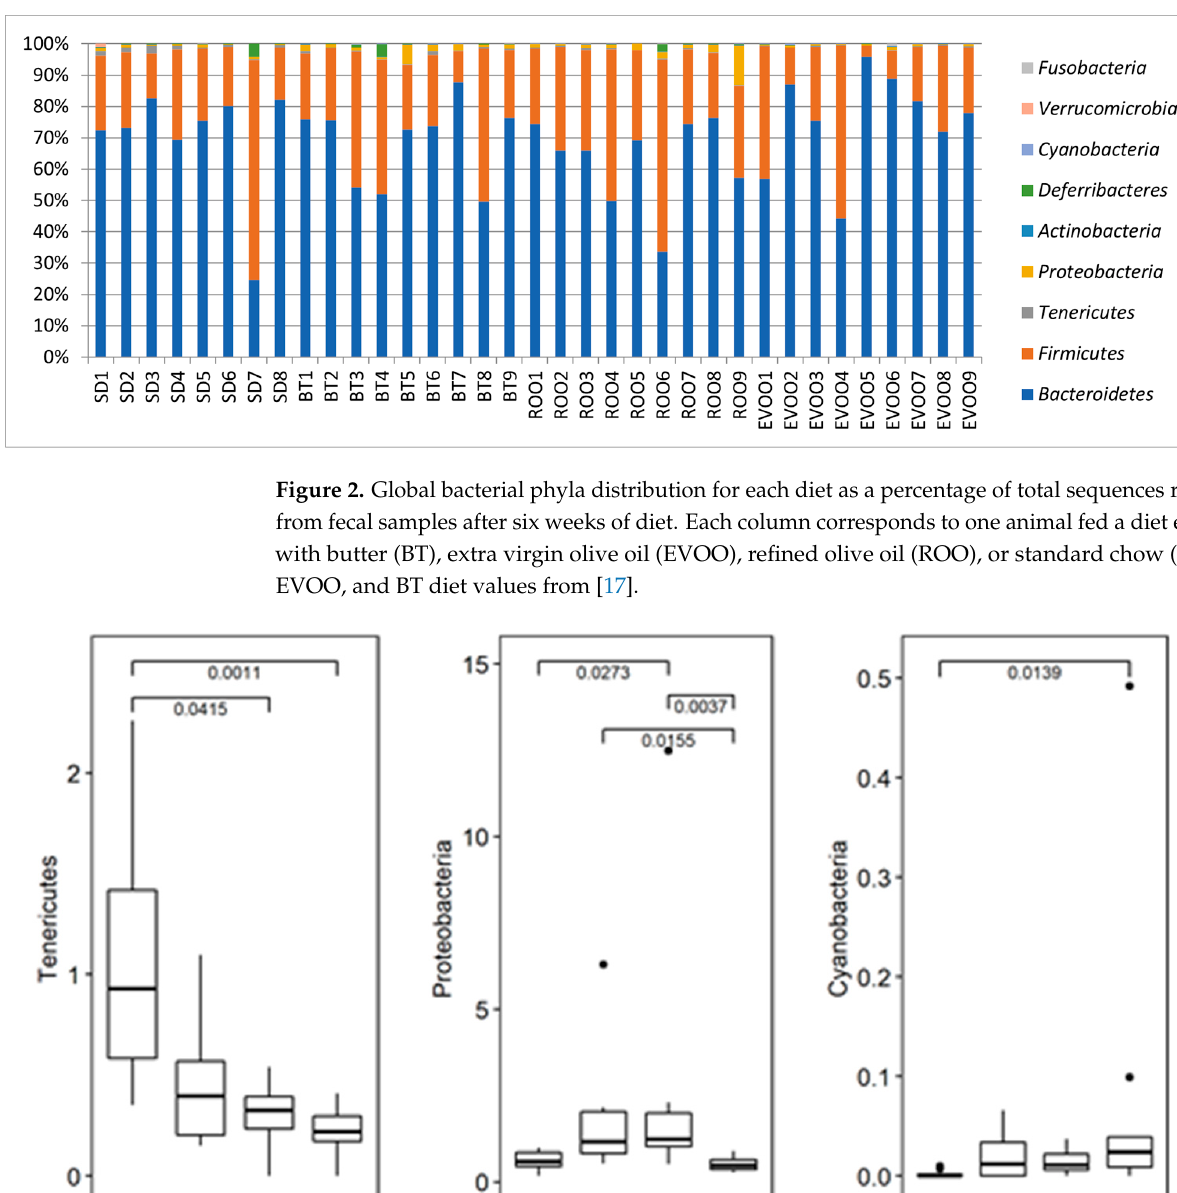
Figure 3. Box plot representation of the percentage distribution of the phyla ( a ) Tenericutes , ( b ) Pro- teobacteria , ( c ) Cyanobacteria , with statistically significant differences in fecal samples from mice fed a diet enriched with butter (BT), extra virgin olive oil (EVOO), refined olive oil (ROO), or standard chow (SD) for six weeks. SD, EVOO, and BT diet values from [17].